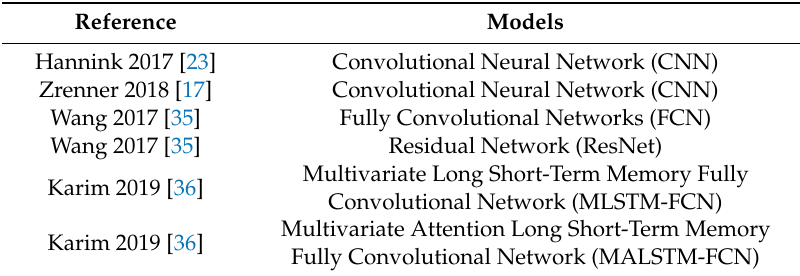
Table 1. Contemporary multivariate time-series deep-learning models for prediction of stride